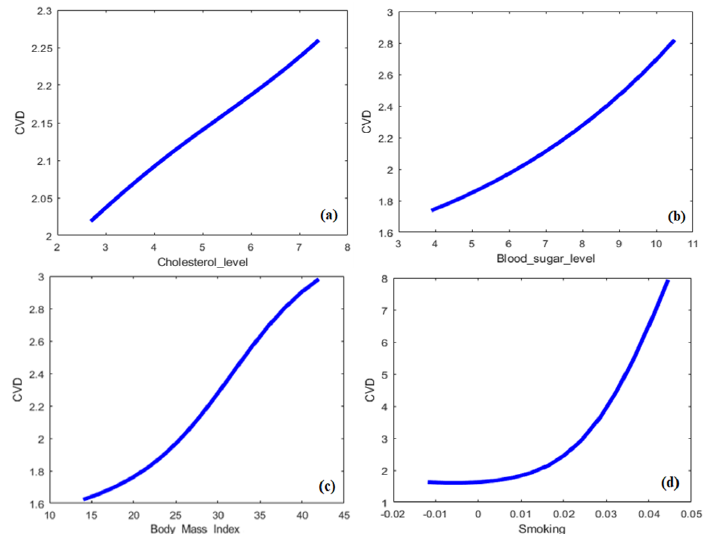
Figure 10. Two-dimensional relations of CVD with cholesterol level, glucose level, BMI and smoking; see abbreviations in Nomenclature.